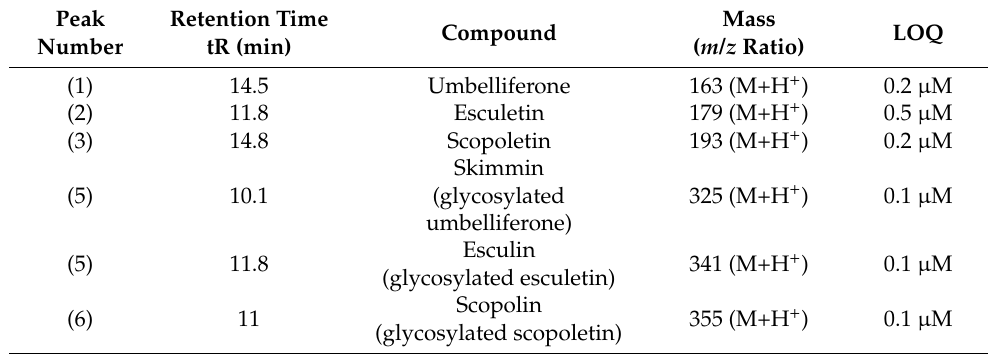
Table 1. Coumarins and their glycosides identified in this